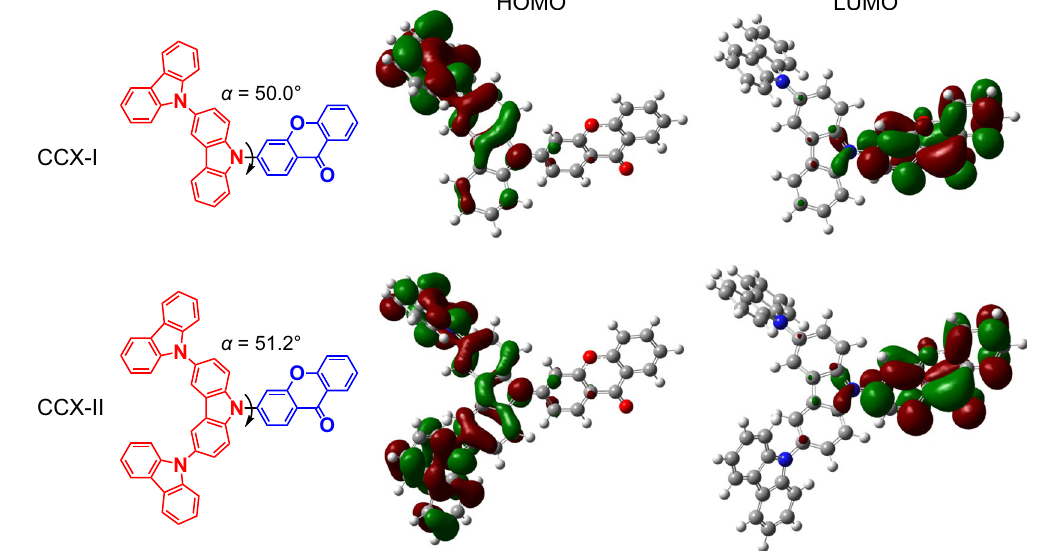
Figure 1. CCX-I and CCX-II. Electron-donating and electron-accepting units are indicated by red and blue, respectively. α is the torsion angle between the electron-donating and electron-accepting units. The isosurface value for the HOMOs and LUMOs is 0.02 a.u.